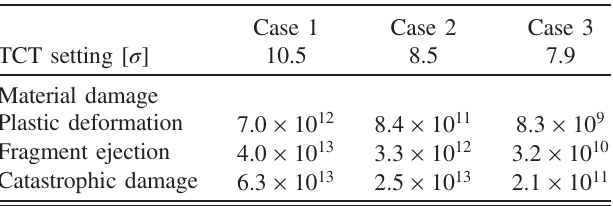
TABLE V. Bunch population at damage (p/b) calculated for the three cases discussed in the paper, which assume different errors in the TCT